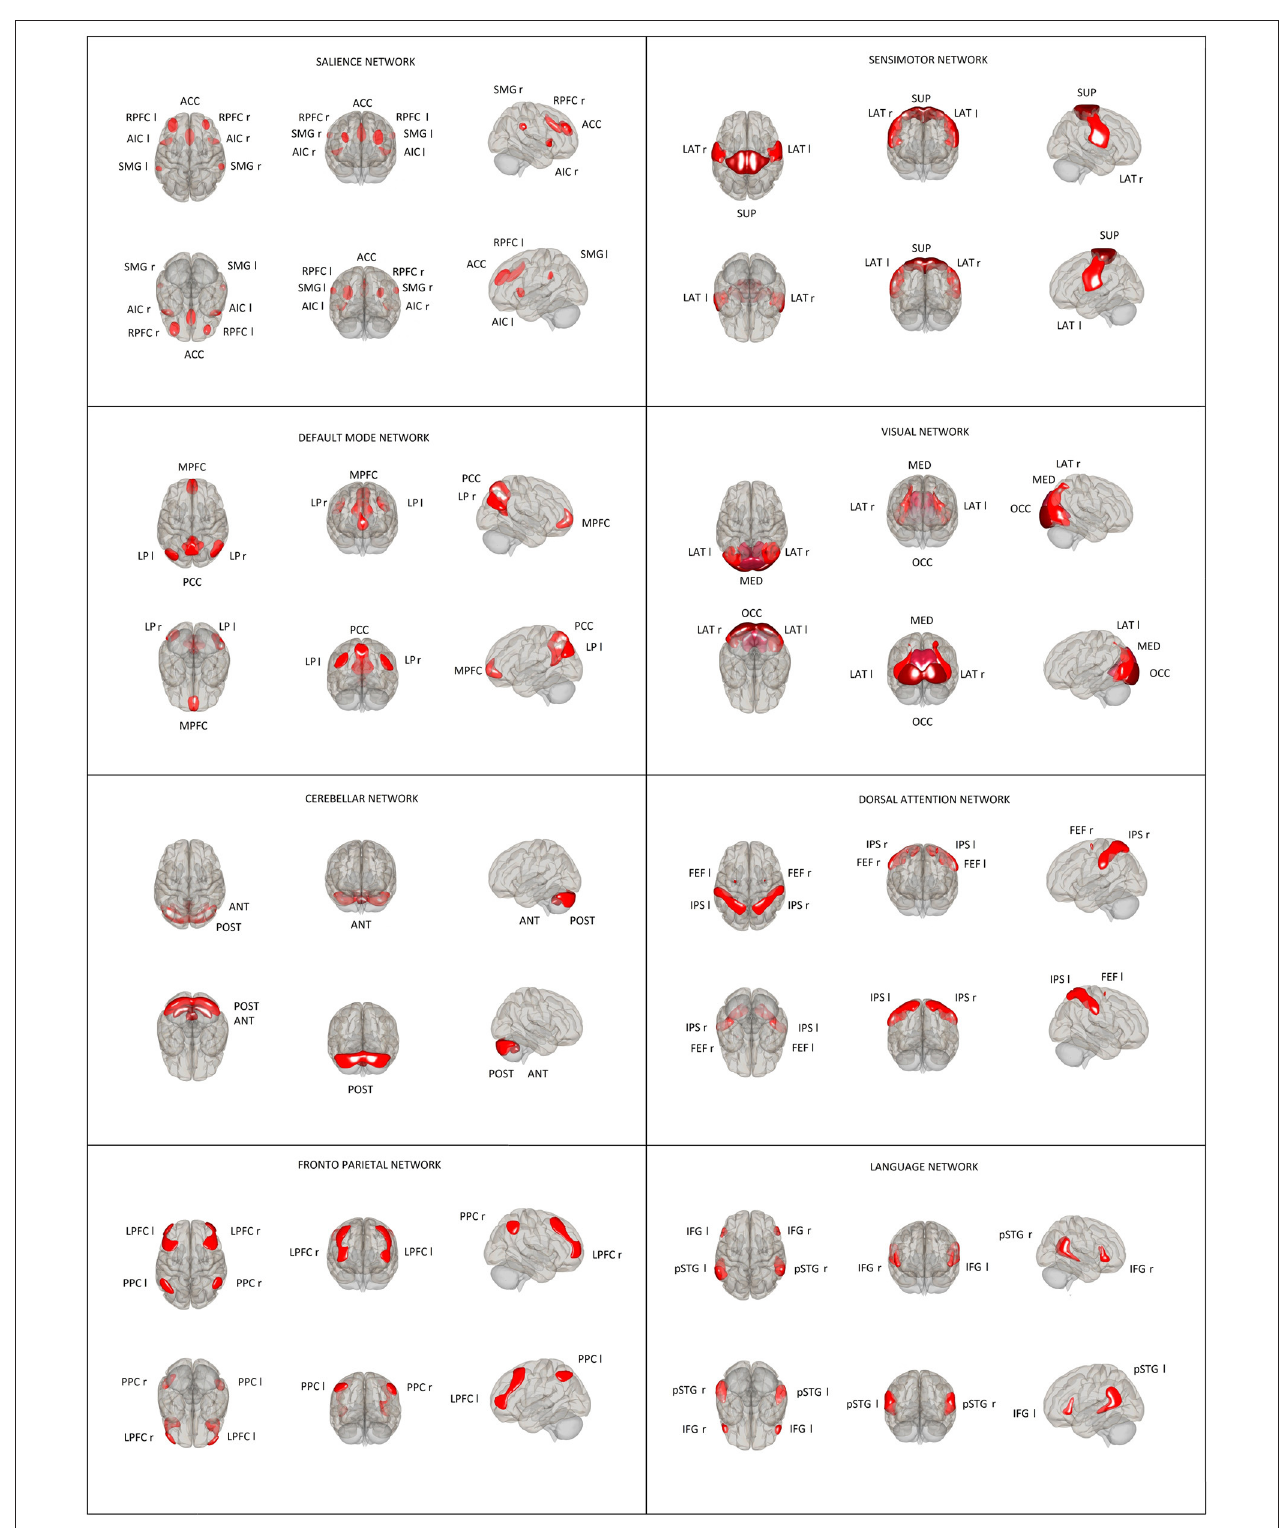
FIGURE 1 | Location and size of predefined rs-network ROIs used in the ROI–ROI analysis. Default mode network (DMN): medial prefrontal cortex (MPFC), precuneus cortex (PCC), bilateral lateral parietal (LP); sensorimotor network (SMN): superior, bilateral lateral; visual network (VIS): medial, occipital, bilateral lateral; salience network (SN): anterior cingulate cortex (ACC), bilateral anterior insula (AI), rostral prefrontal cortex (RPFC), and supramarginal gyrus (SMG); dorsal attention network (DA): bilateral frontal eye field (FEF) and intraparietal sulcus (IPS); fronto-parietal network (FPN): bilateral lateral prefrontal cortex (LPFC) and posterior parietal cortex (PPC); language network (LAN): bilateral inferior frontal gyrus (IFG) and posterior superior temporal gyrus (pSTG); and cerebellar network (CER): anterior, posterior.